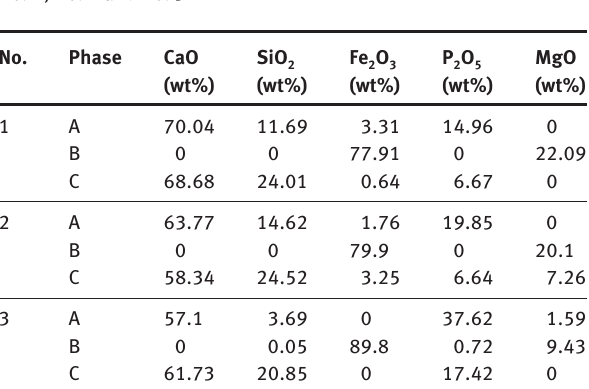
Table 2: The results of the energy spectrum analysis for sample No. 1, No. 2 and No. 3